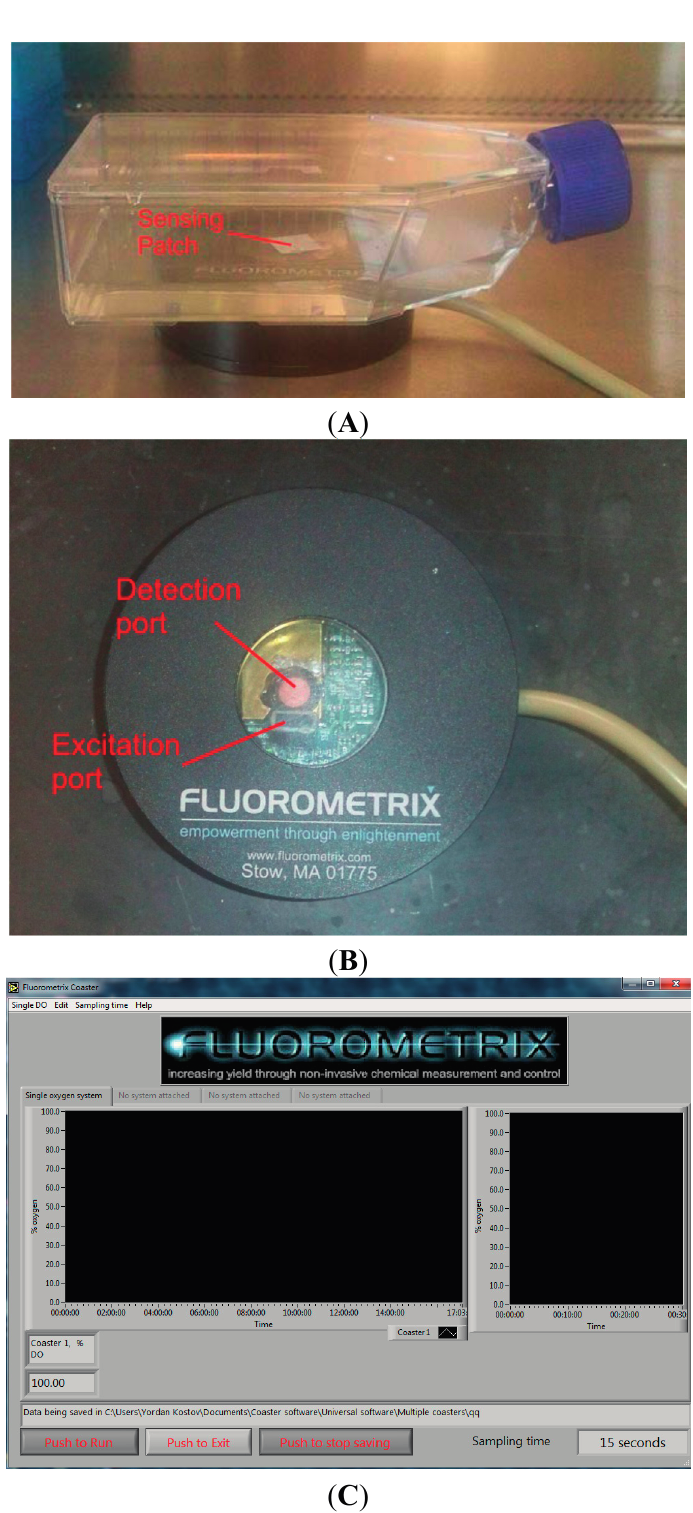
Figure 3. ( A ) Fluorometrix Coasters; ( B ) Fluorometrix Coasters monitoring culture flask; ( C ) Fluorometrix data recording